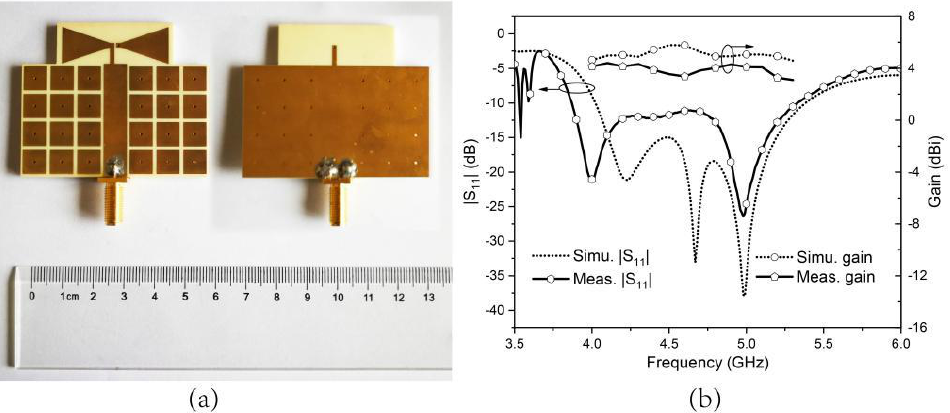
Figure 7. ( a ) Photo of the fabricated MTM-based wideband antenna. ( b ) Simulated and measured | S | and gain values. 11